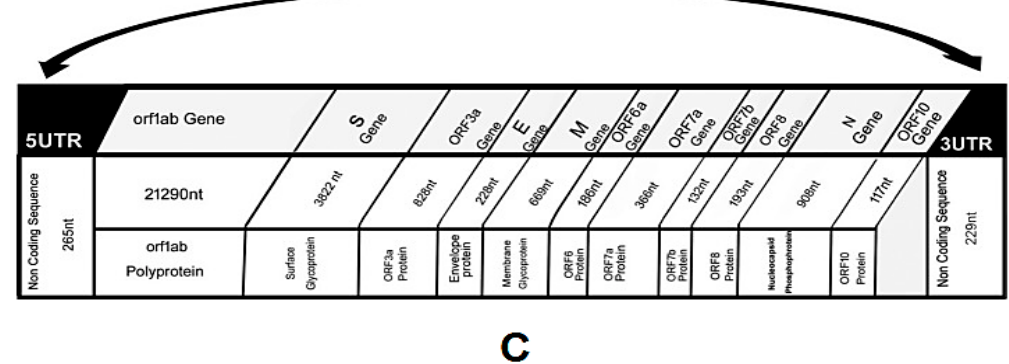
Figure 14. ( A ) Target candidates and their related drug candidates. ( B ) SARS-CoV-2 illustration [82]. ( C ) Genomic characterization of SARS-CoV-2, reproduced with permission from Ref. [83].